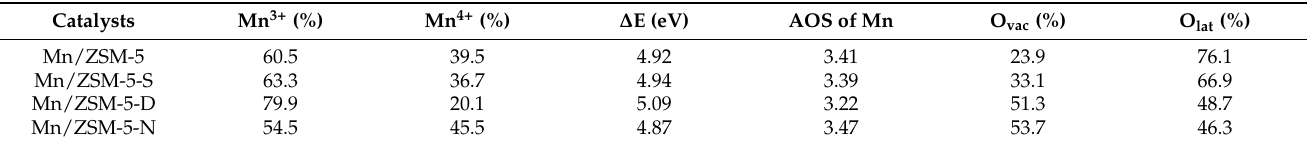
Table 2. Atomic ratio of Mn ions and oxygen